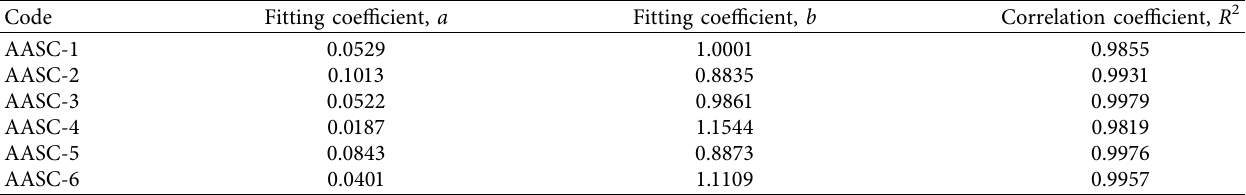
Figure 18: Relative dynamic elastic modulus accumulative damage exponential function model. Table 14: Relative dynamic elastic modulus accumulative damage power function and pertinence coefficient.